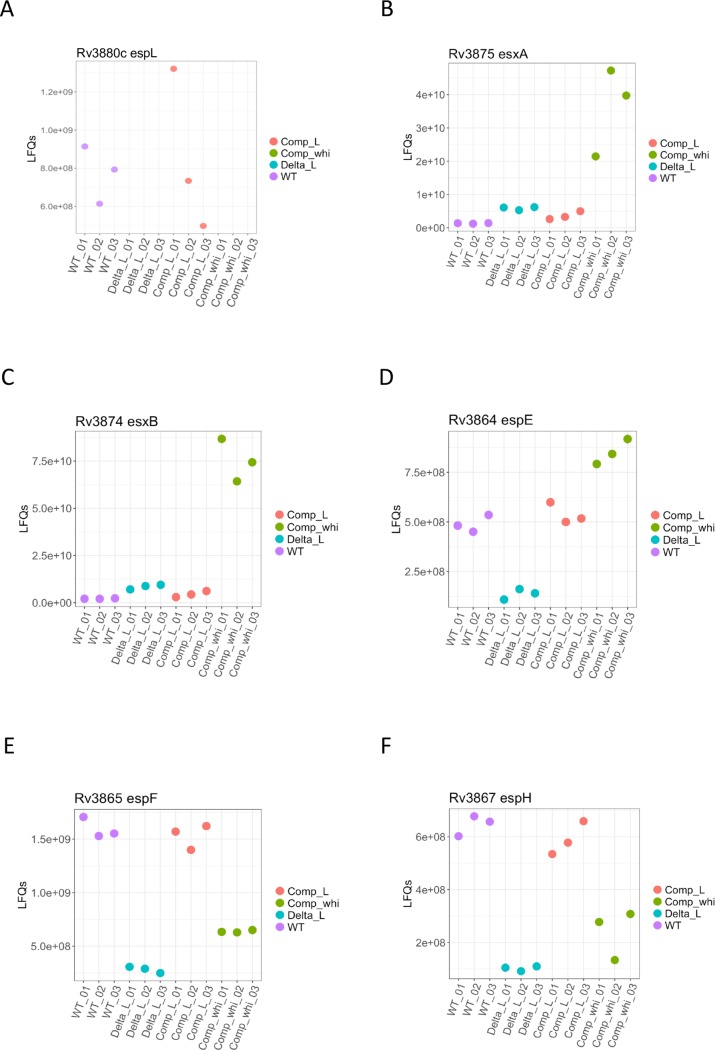
Mass spectrometry analysis of protein abundance in the ΔespL mutant.Total protein extracts were prepared in triplicate and subjected to Mass Spectrometry analysis. Each graph shows the abundance of the indicated protein in the three replicates in the various strains. A) EspL. B) EsxA. C) EsxB. D) EspE. E) EspF. F) EspH. WT: H37Rv. Delta_L: ΔespL. Comp_L: ΔespL/espL (complemented strain). Comp_whi: ΔespL/whiB6 (strain expressing whiB6 in trans). Data are expressed as LFQs (Label Free Quantifications).